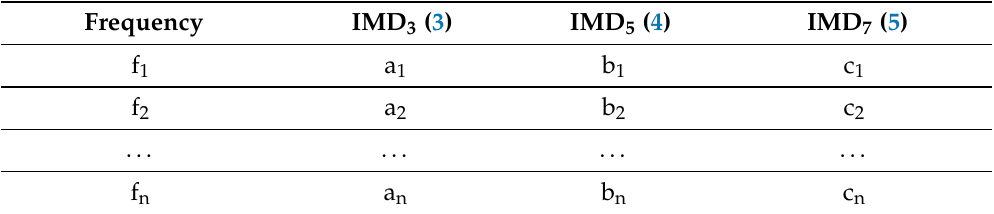
Table 1. Summarized IMD level data obtained from